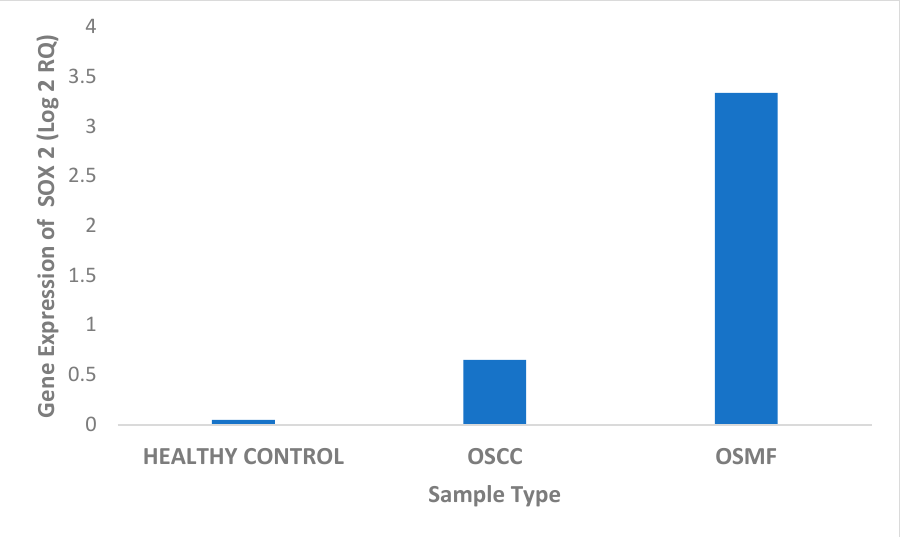
Figure 3. Di ff erential expression of OCT 3/4 in di ff erent tissue samples. Figure 3. Differential expression of OCT 3/4 in different tissue samples.